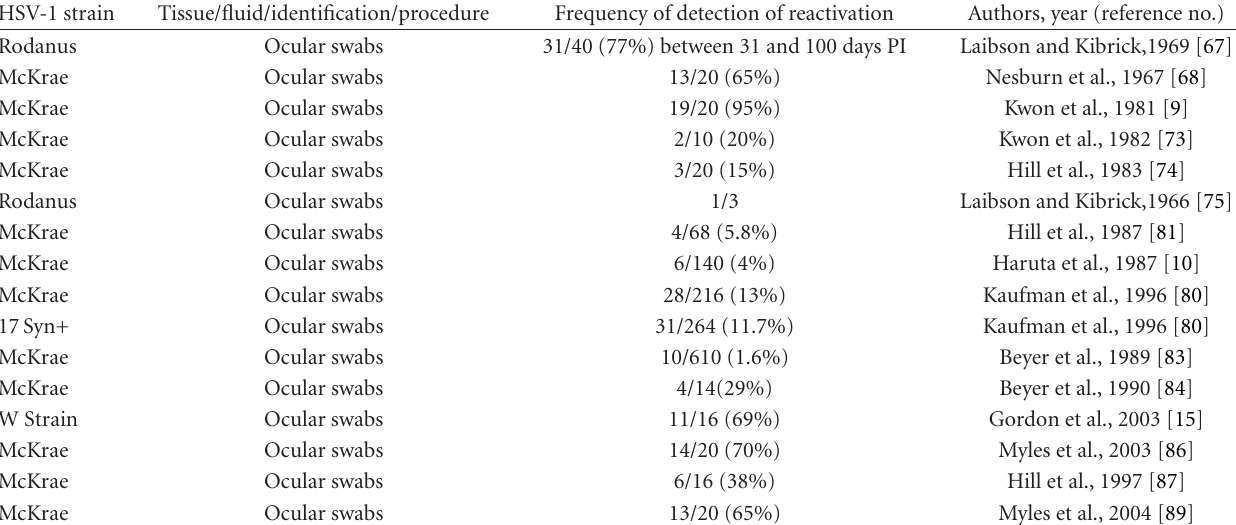
Table 5: Spontaneous shedding of infectious HSV-1 in latent